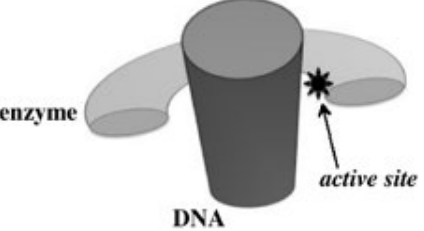
Figure 4. Cartoon of the problem of restriction enzymes. The enzyme cuts a DNA strand at a specific sequence of nucleotides. The star represents the enzyme active site. Adapted from Ref. 62b with permission of Springer.